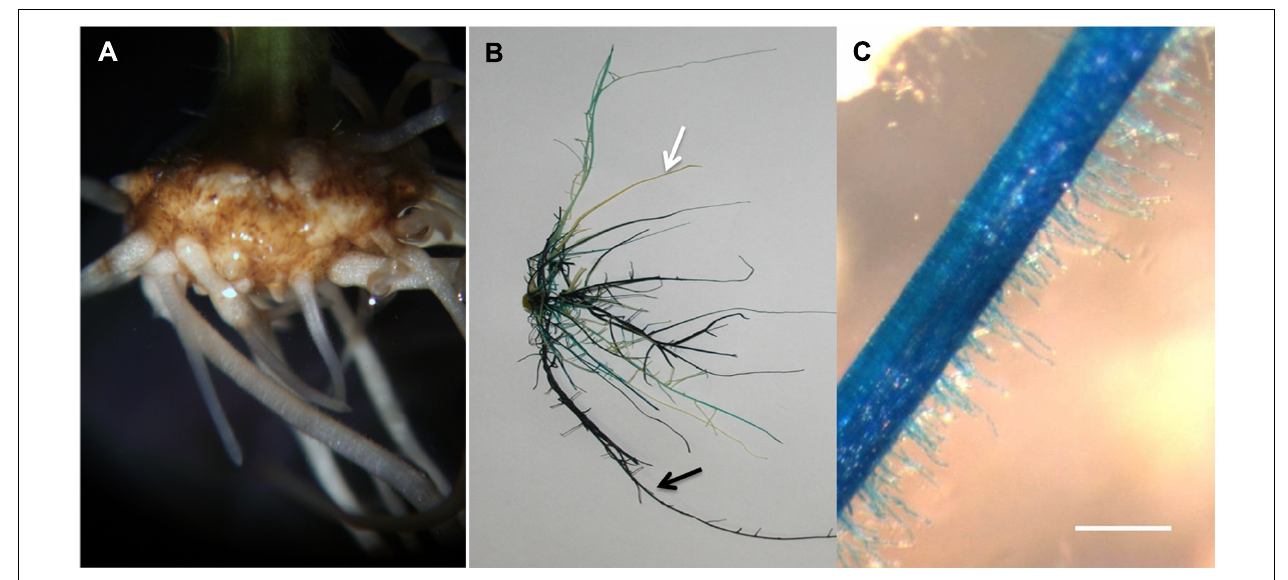
FIGURE 5 | Soybean transgenic roots and root hairs generated in the ultrasound areoponic system; (A) transgenic roots emerging from the callus 10 days after Agrobacterium rhizogenes inoculation;